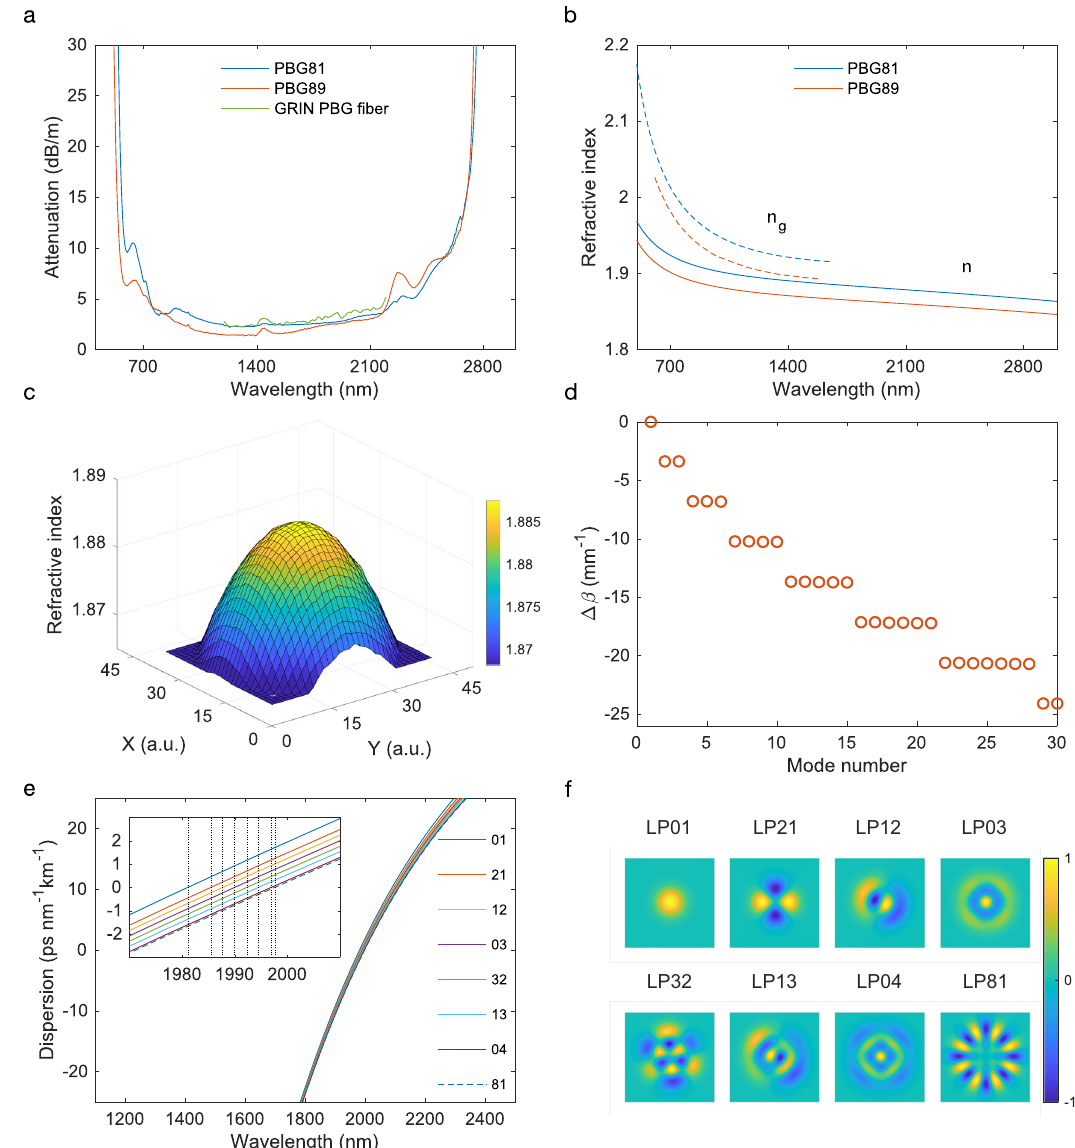
Fig. 1 Lead-bismuth-gallate (PBG) graded-index multimode optical fi ber characteristics. a Experimentally measured attenuation of the bulk PBG-81 (blue) and PBG-89 (red) constituent glasses. The attenuation of the fabricated GRIN fi ber is shown in green. b Measured group refractive index n g of PBG- 81 (blue dashed) and PBG-89 (red dashed). The calculated refractive index n using the extracted Sellmeier coef fi cients from the measured group index (see Methods) is shown as blue and red solid lines for PBG-81 and PBG-89, respectively. c Simulated 3D average refractive index distribution of the fi ber structure. d Propagation constant difference Δ β of the fi rst 30 modes (with respect to the fundamental mode) of the fi ber with 80 μ m core diameter and refractive-index pro fi le as in c . e Dispersion pro fi les of the PBG fi ber fundamental and selected higher-order LP modes. The inset in ( e ) shows a magni fi ed view of the dispersion pro fi le near the zero-dispersion region where the vertical dashed lines mark the position of the ZDW. f Spatial amplitude distribution corresponding to the dispersion pro fi le of the modes shown in e .